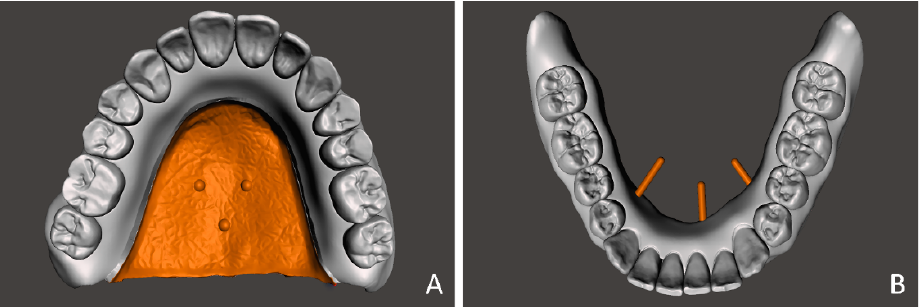
Figure 1. Design of metal-reinforced complete dentures. Yellow portion represents the metal frame-